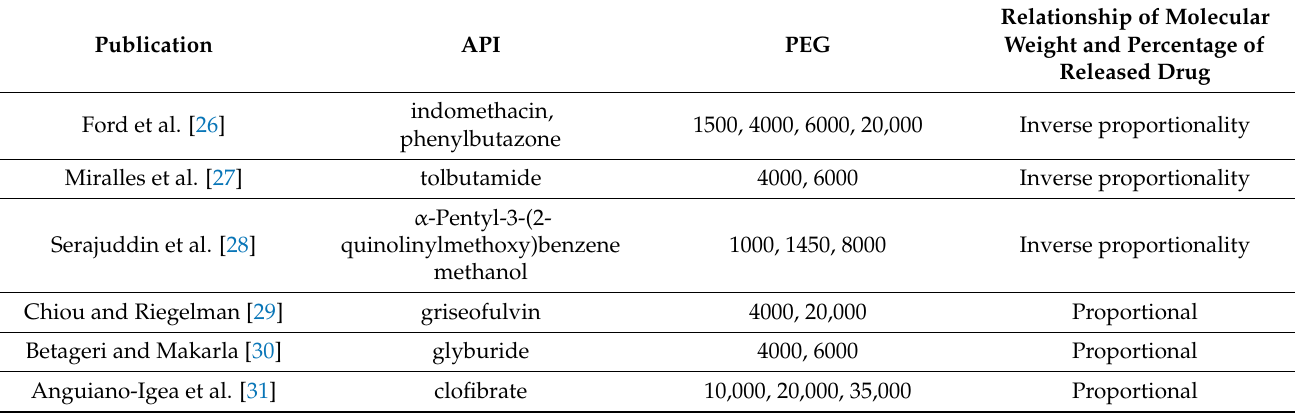
Table 1. Literature review of dissolution studies which involved solid dispersions, prepared with multiple